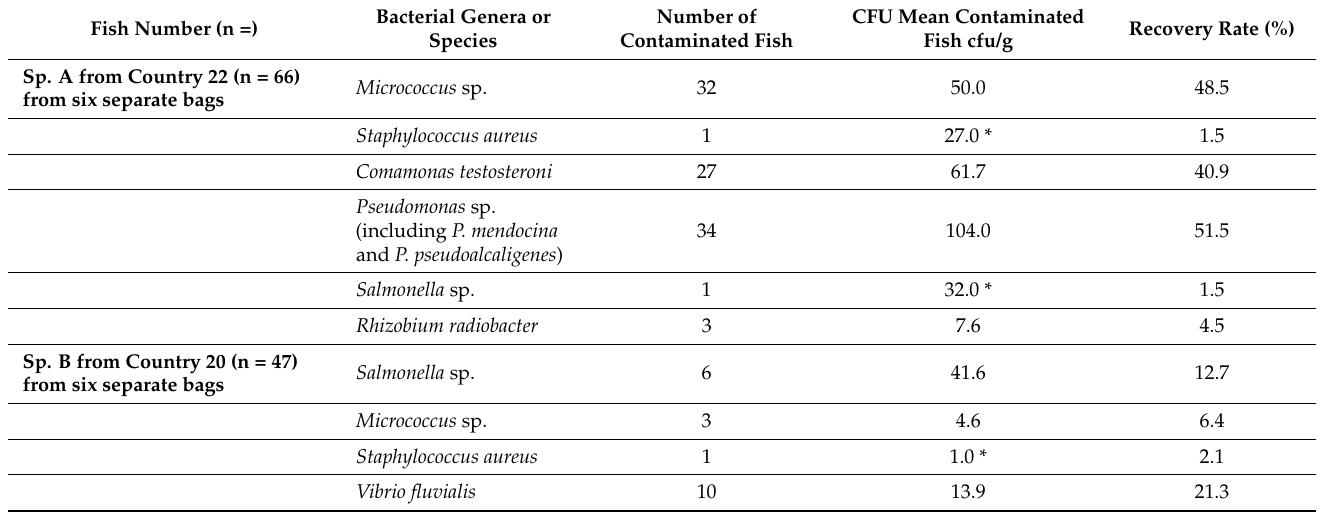
Table 2. List and number of bacteria found between the two species of imported fish colonies per gram (cfu/g). Bag water from Sp. A (n = 6) and Sp. B. (n = 6) has been included in the fish overall number. Mean not calculated when only one fish contaminated *.